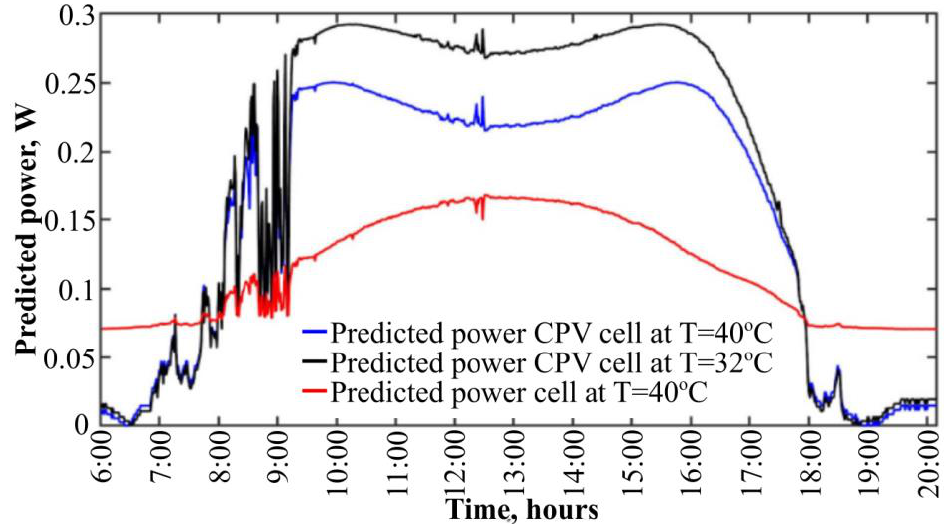
Figure 15. Energy generation by silicon solar cell and LCPV during the day.